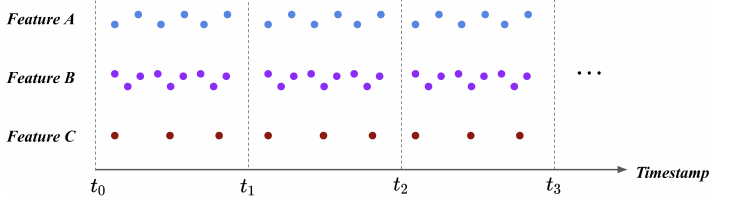
Figure 2. Flight logs before timestamp pooling. Along with the feature type, there exists a different number of values during a single time window. As the model receives a fixed-size input, timestamp pooling is required to transform the flight logs into the fixed-size feature